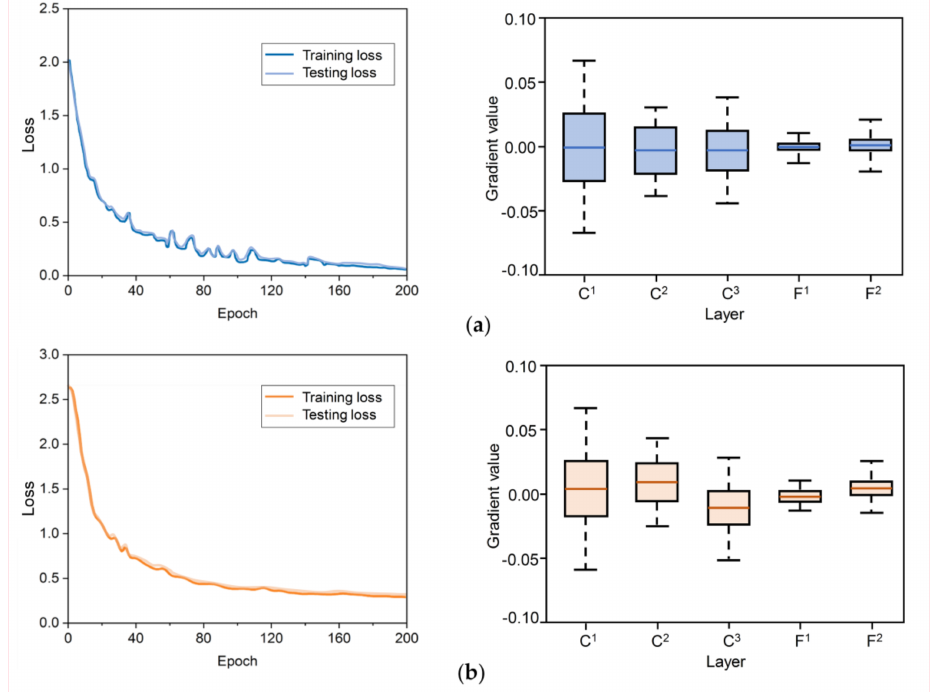
Figure 4. The training processes of the BMF-CNN and baseline CNN (traditional). ( a ) The losses of BMF-CNN and box plot of the gradients of the BMF-CNN; ( b ) the losses of traditional CNN and box plot of the gradients of the traditional CNN.